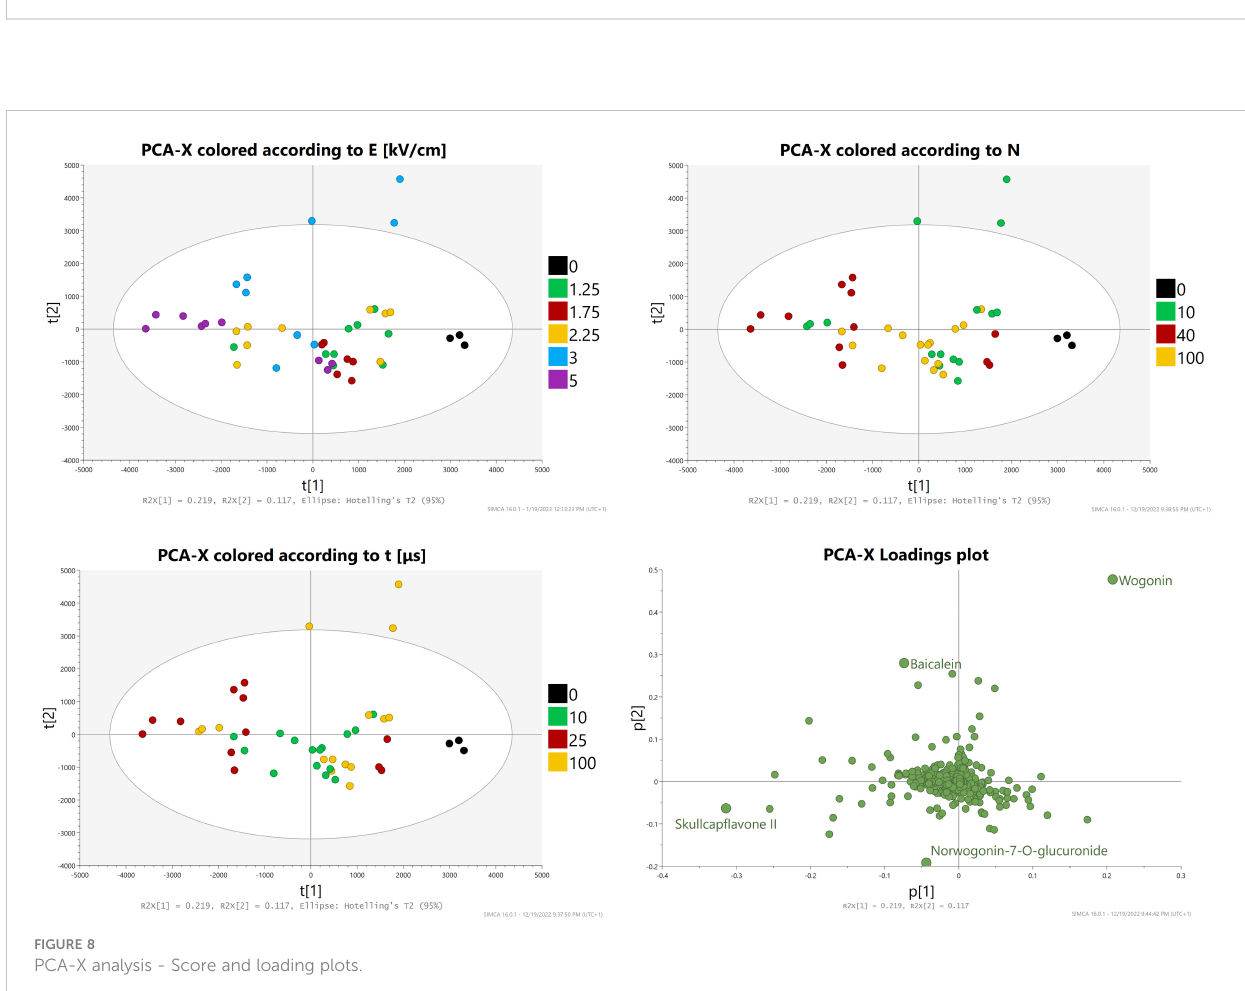
FIGURE 8 PCA-X analysis - Score and loading